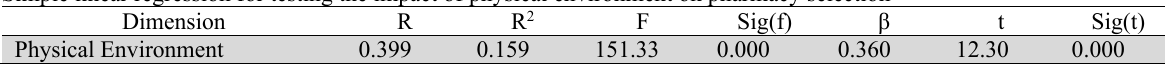
Simple linear regression for testing the impact of physical environment on pharmacy selection Dimension